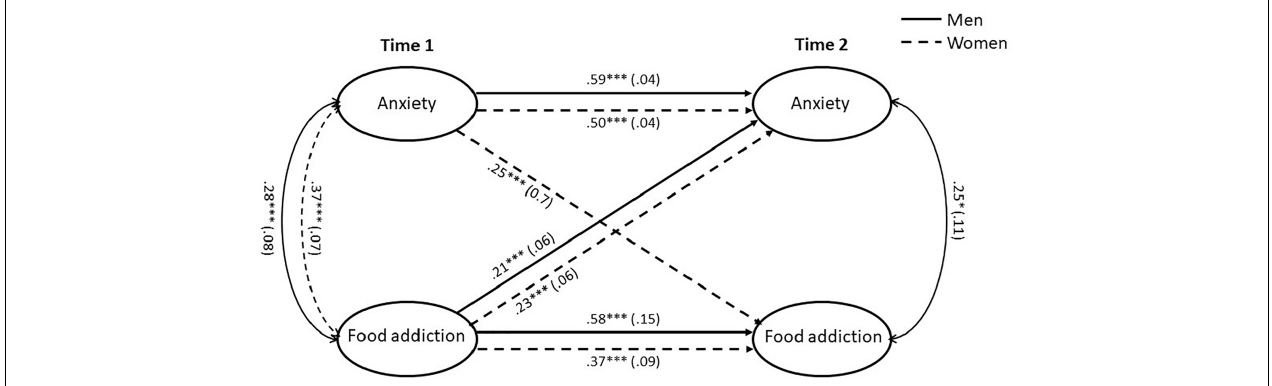
FIGURE 2 | Multiple-group latent autoregressive cross-lagged panel model with standardized beta coefficients and standard errors in parentheses. The model only displays the significant paths for men and women. The effects of control variables (age, marital status, socioeconomic status, social support) on anxiety and food addiction at time 1 were included in the estimation but not shown for ease of presentation. Sample size: 1,474 (48.2% female). ∗ p ≤ 0.05; ∗∗∗ p ≤